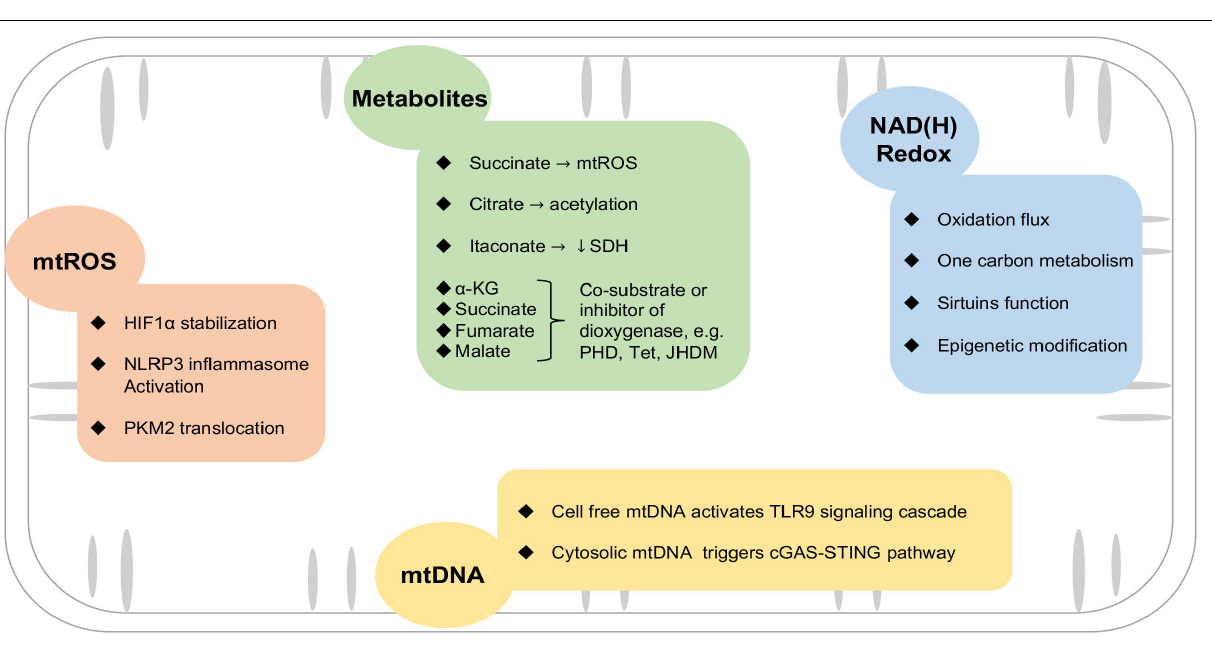
isoprenaline treatment (Shan et al., 2017), suggesting